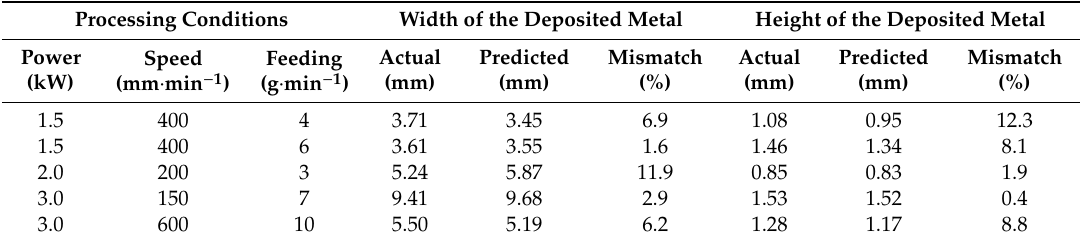
Table 4. Actual and simulated responses with absolute percentage mismatch for each processing condition, to validate the regression model.